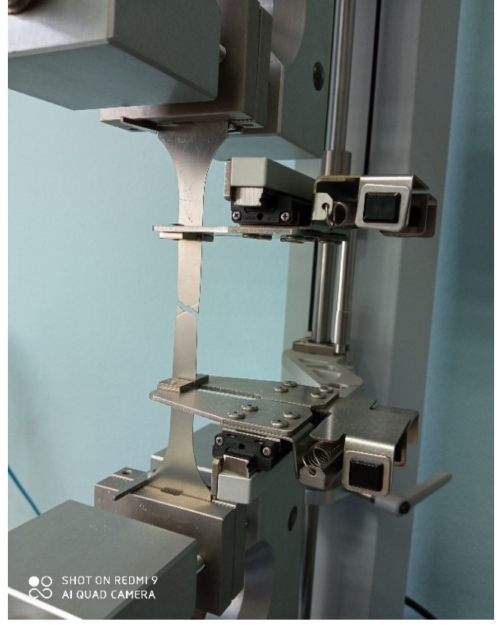
Figure 4. Shimadzu AGS-X 10 kN testing